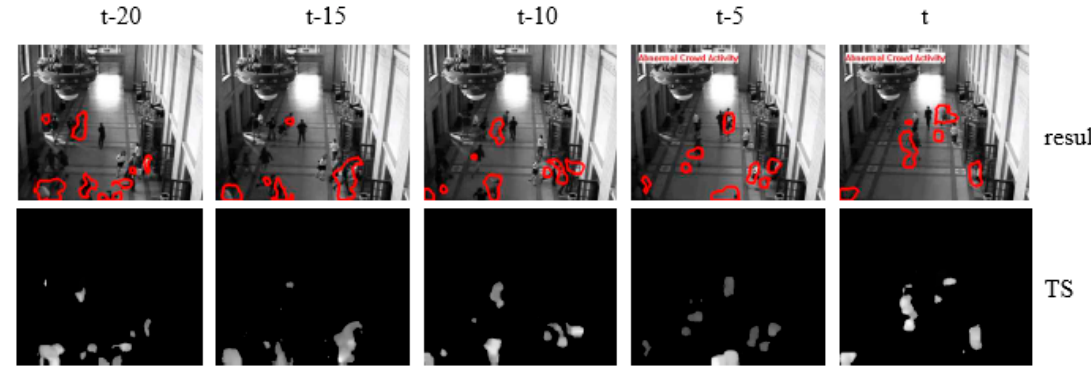
Figure 9. Examples of detection results for abnormality from No. 2 data (UMN Scene 2: Indoor).